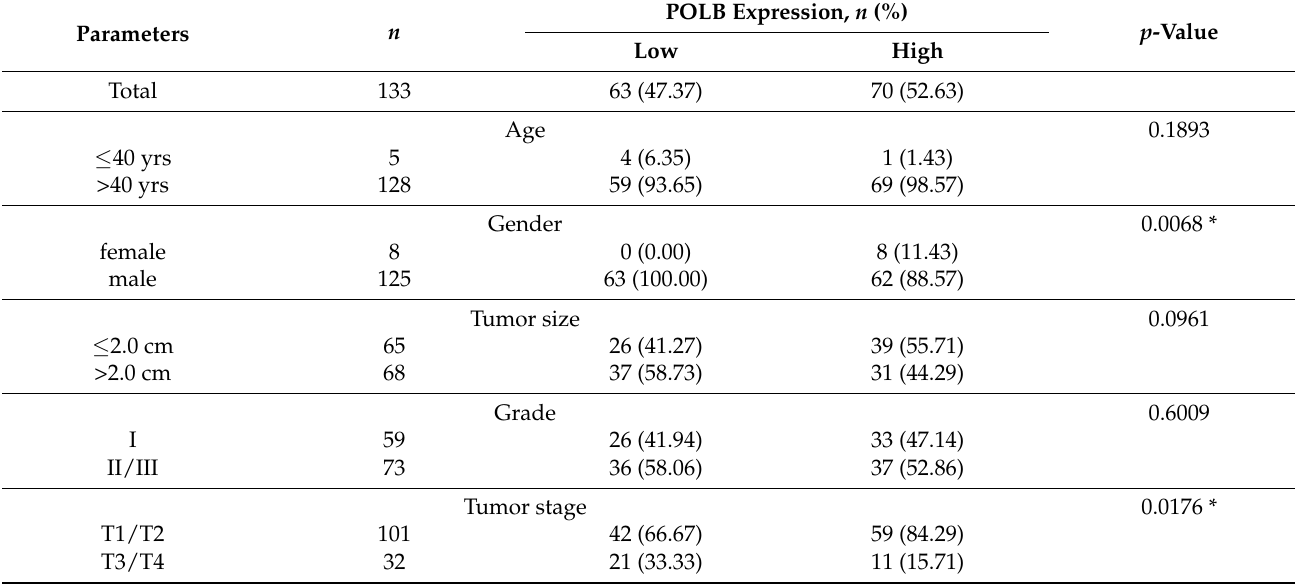
Table 2. Relationship between POLB expression and clinicopathological characteristics of oral cancer patients ( n = 133). Statistical analysis was performed using the Chi-squared